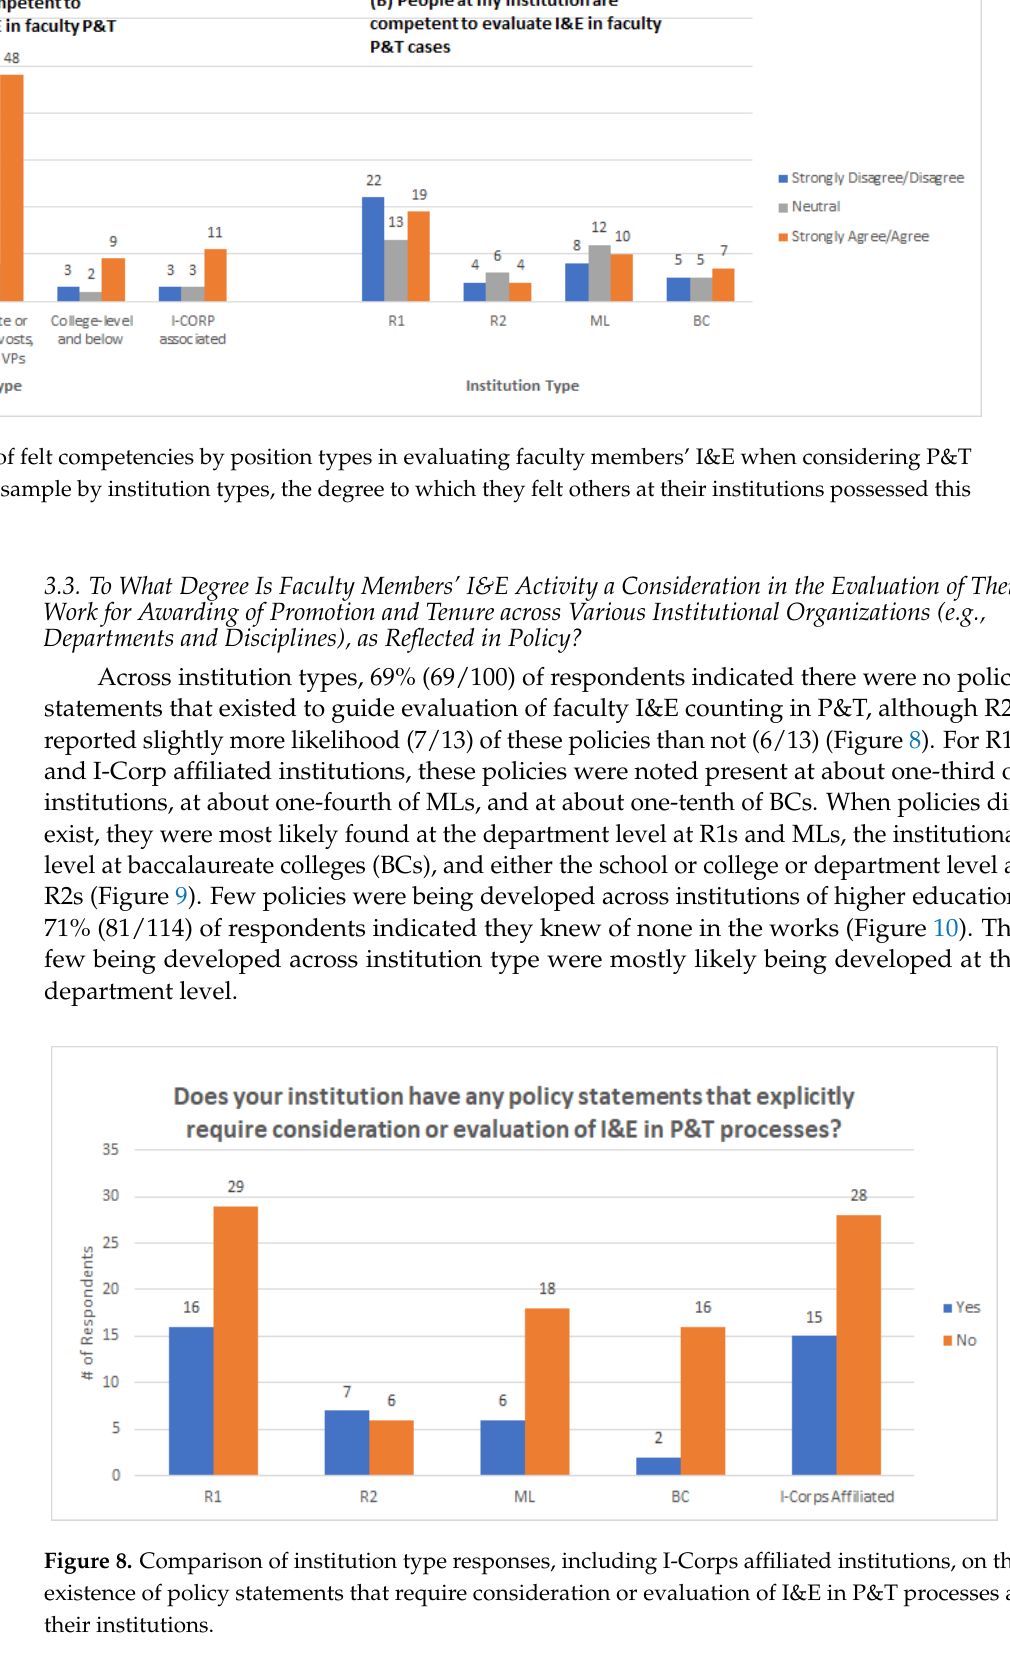
Figure 9. Comparison of institution type responses of the level where I&E related P&T policy state- ments apply at their institutions. Figure 10. Comparison of institution type responses, including I-Corps affiliated institutions, whether policy statements are being developed that require consideration of I&E in P&T processes at their institutions.